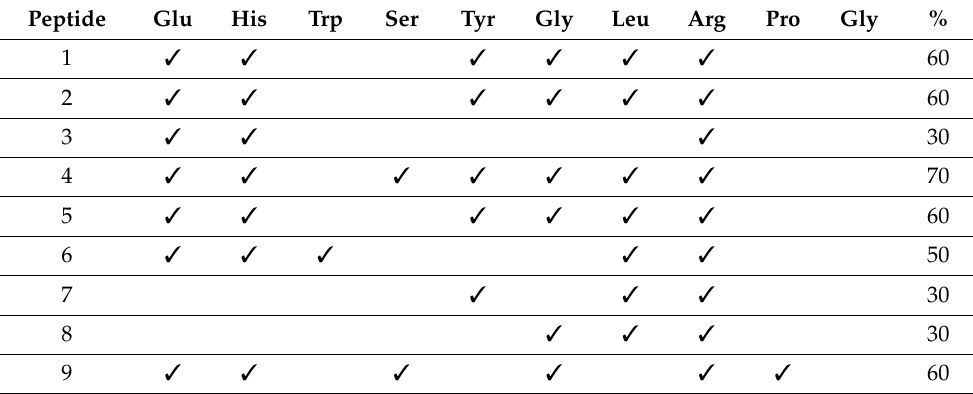
Table 3. Peptide amino acids in contact with the silica surface at the end of the adsorption simulation. The percentage of each peptide’s amino acids in contact with the surface is shown in the final column. Peptide Glu His Trp Ser Tyr Gly Leu Arg Pro